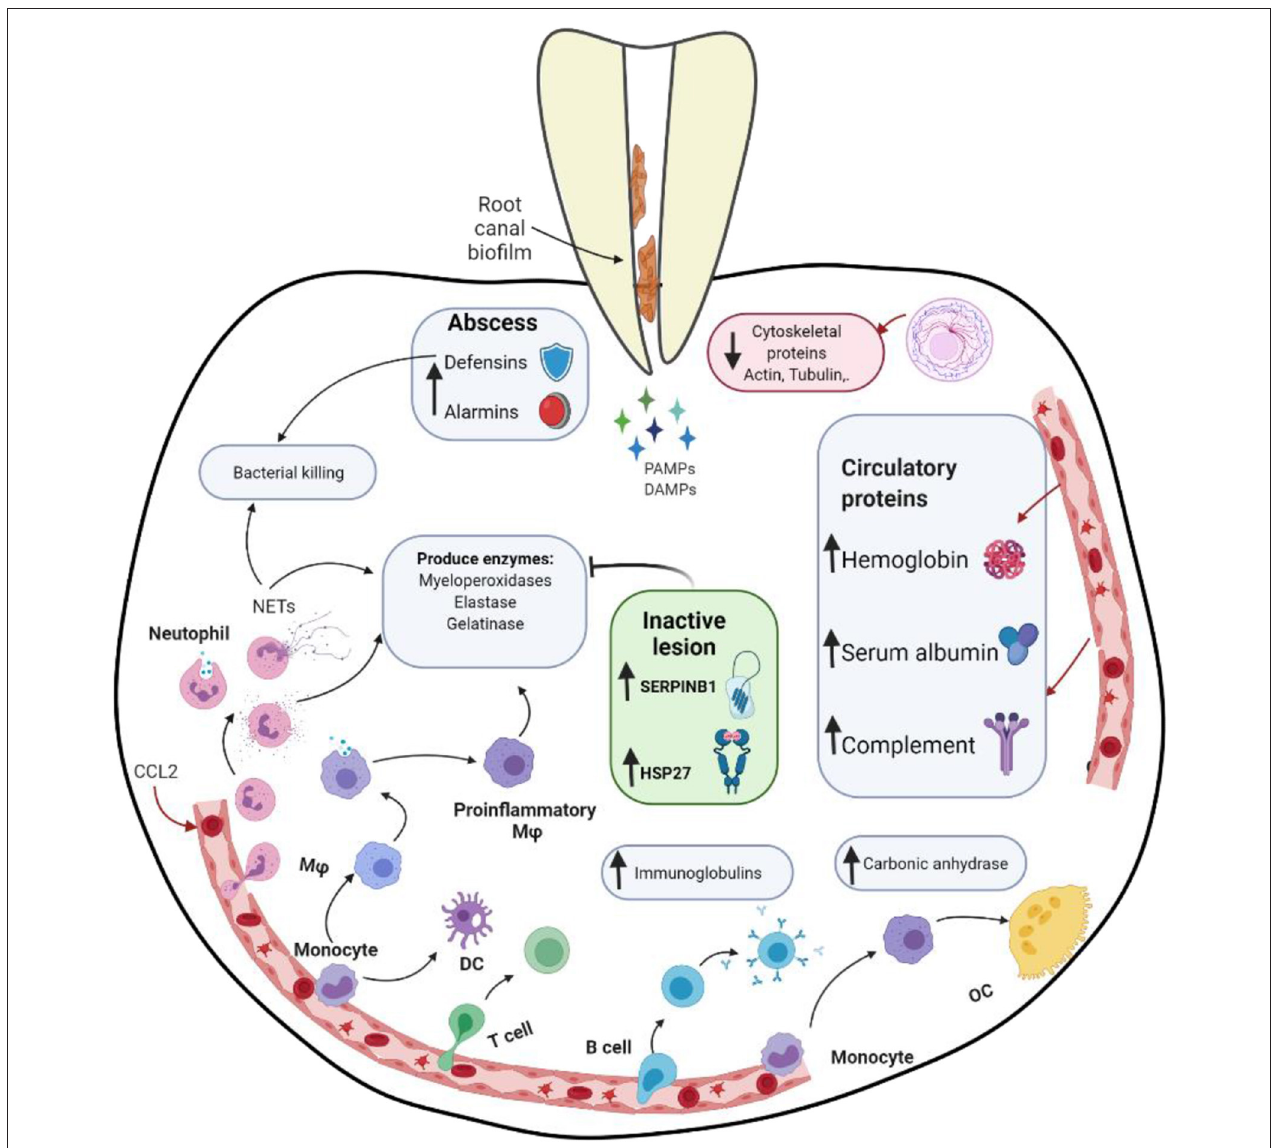
FIGURE 3 | Schematic representing different proteins expression and interactions in apical periodontitis. DAMPs, danger associated molecular patterns; DC, dendritic cell; M ϕ , macrophage; NET, neutrophil extracellular traps; OC, osteoclast; PAMPs, pathogen associated molecular patterns; SERPINB1, Serpin Family B Member 1. Schematic created with